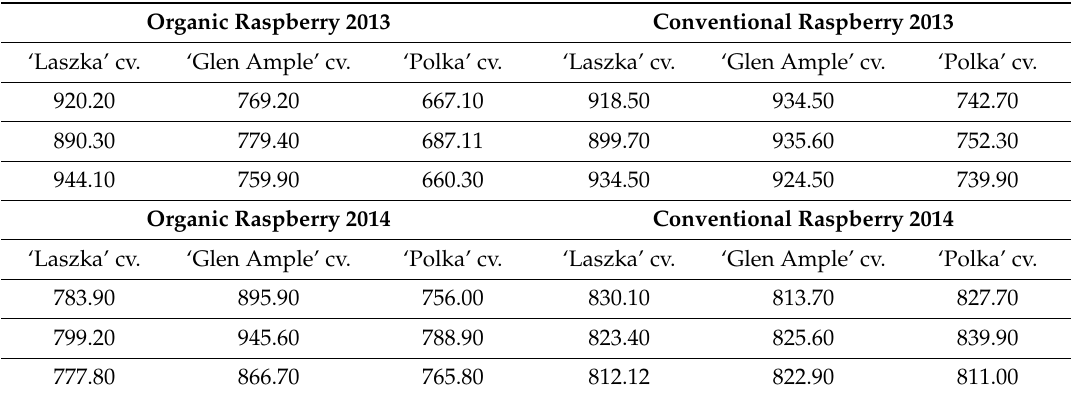
Table 4. The content of Bet v1 as ELISA results ng / g DW.